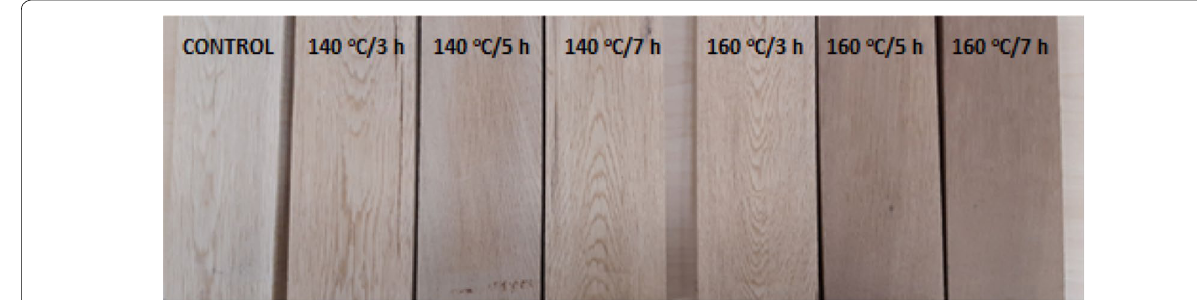
Fig. 8 Color change in oak after heat treatment